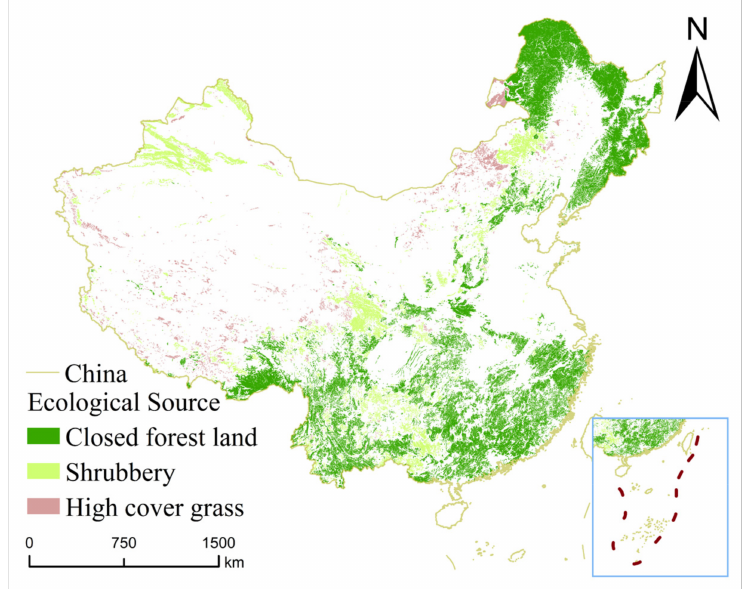
Figure 4. Ecological sources of the study